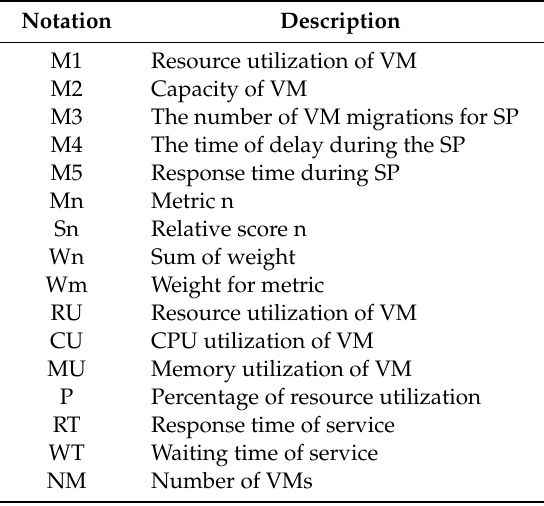
Table 8. Notation used in this